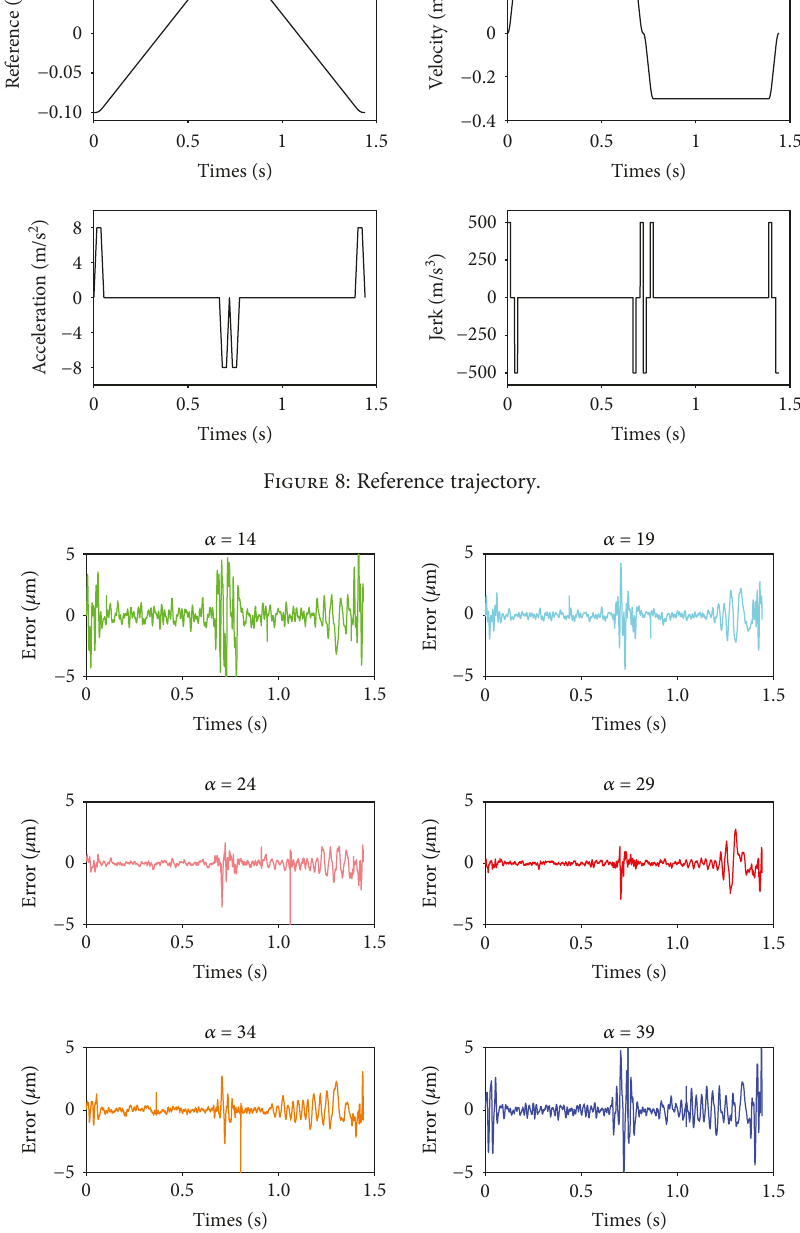
Figure 9: Converged tracking errors with di ff erent times